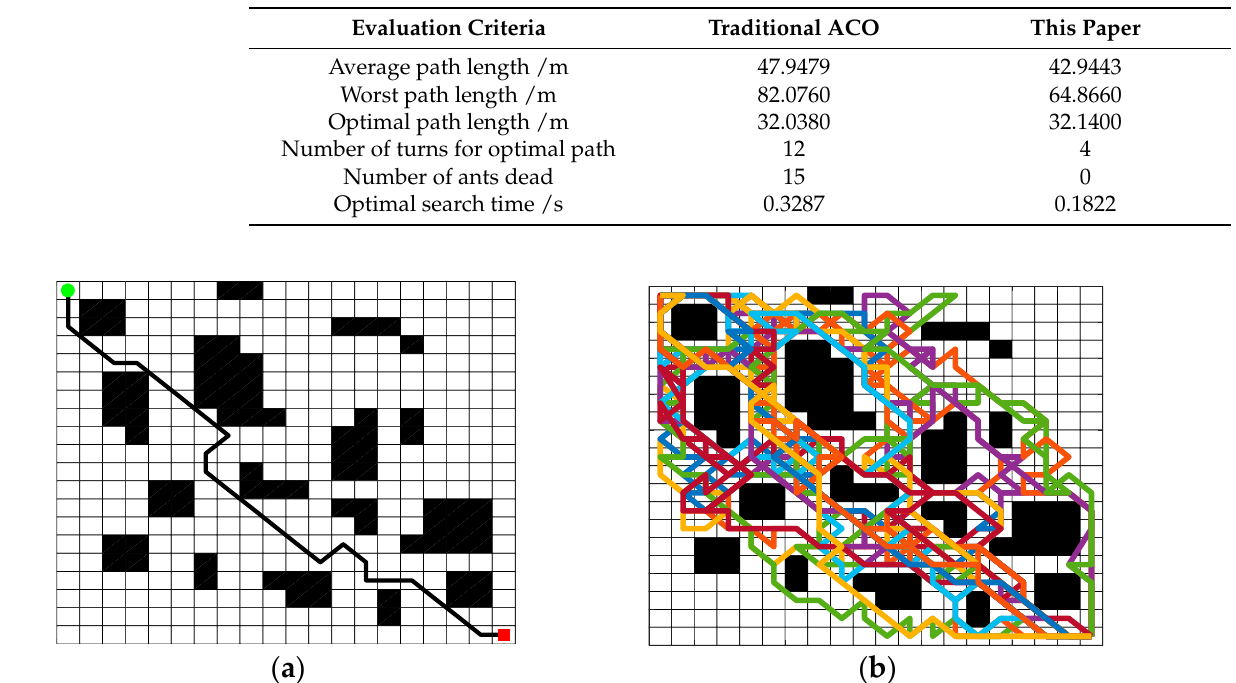
Figure 11. Diagram of the optimal path of ACO; ( a ) Optimal path diagram; ( b ) All ants’ paths diagram.